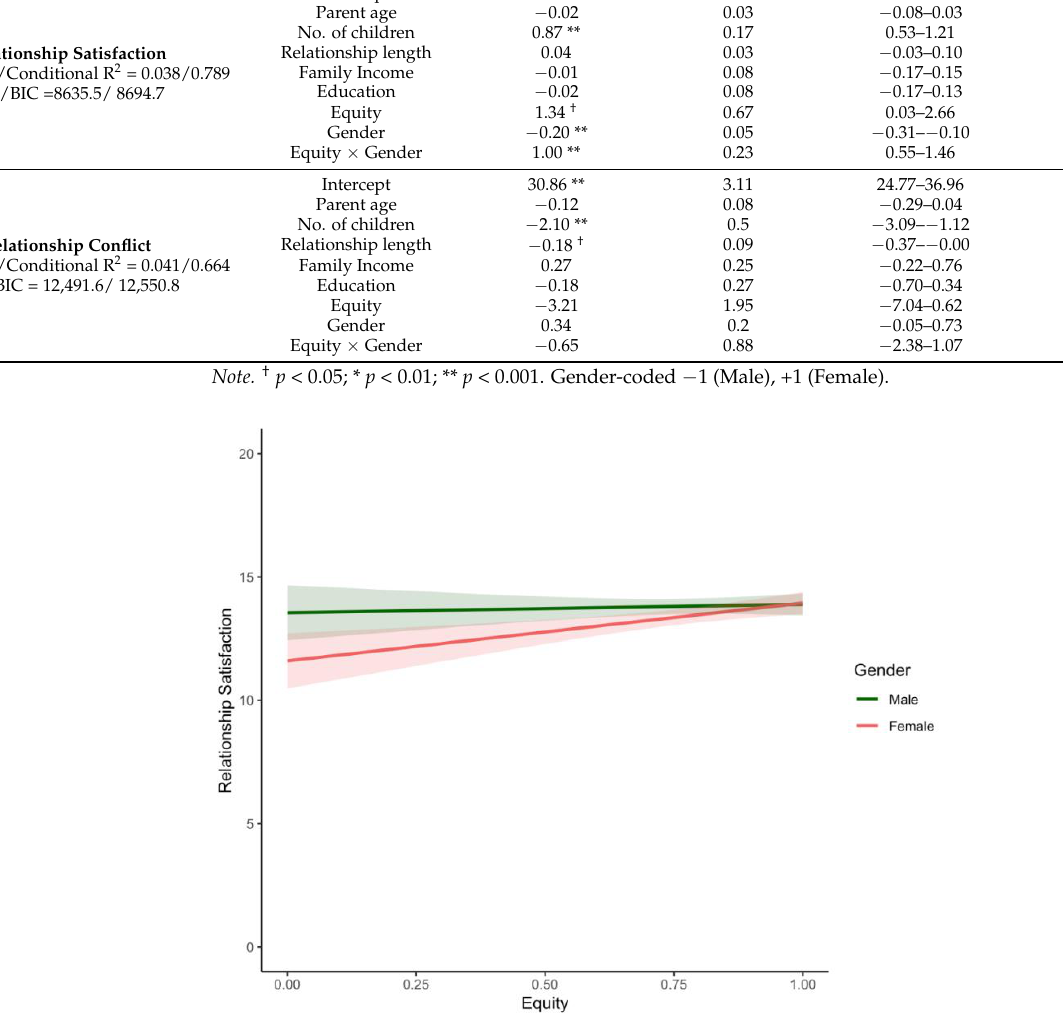
Figure 2. Simple slopes analyses demonstrating the interaction between equity and gender on parents’ relationship satisfaction in mixed-sex couples.